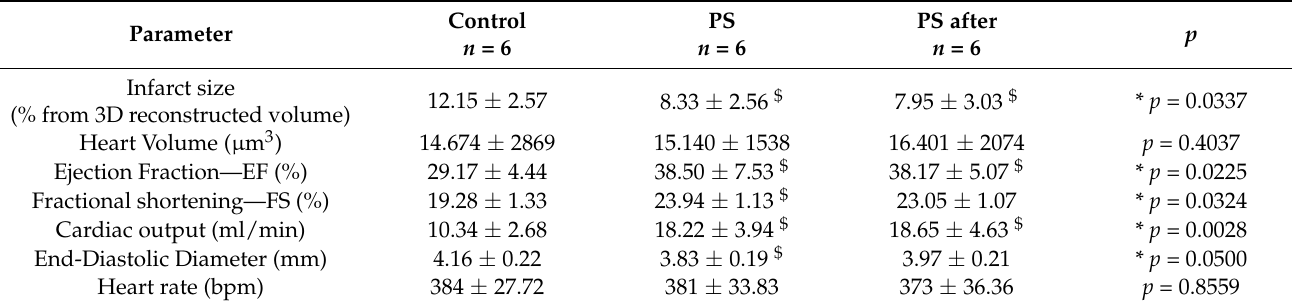
Table 1. Detailed histological measurements (infarction size, heart volume) and echocardiographic parameters (EF, FS, End-Diastolic Diameter, Heart rate, Cardiac